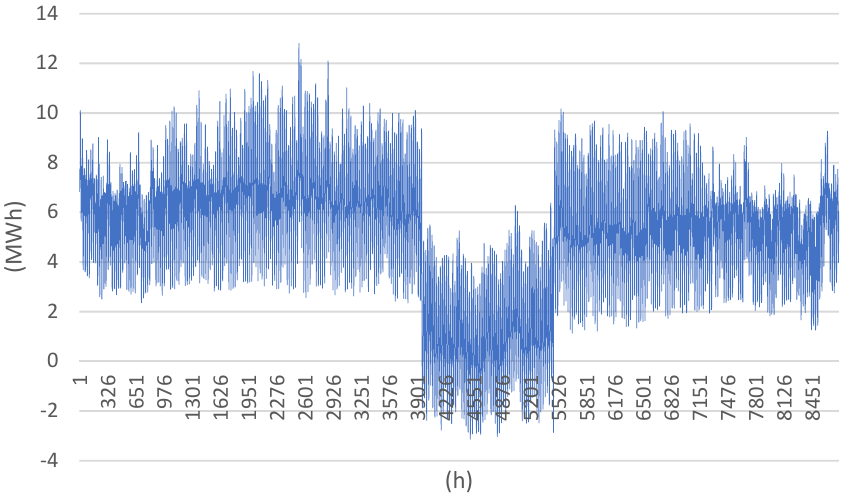
Figure 17. Hourly balance of production and demand (R2 scenario).